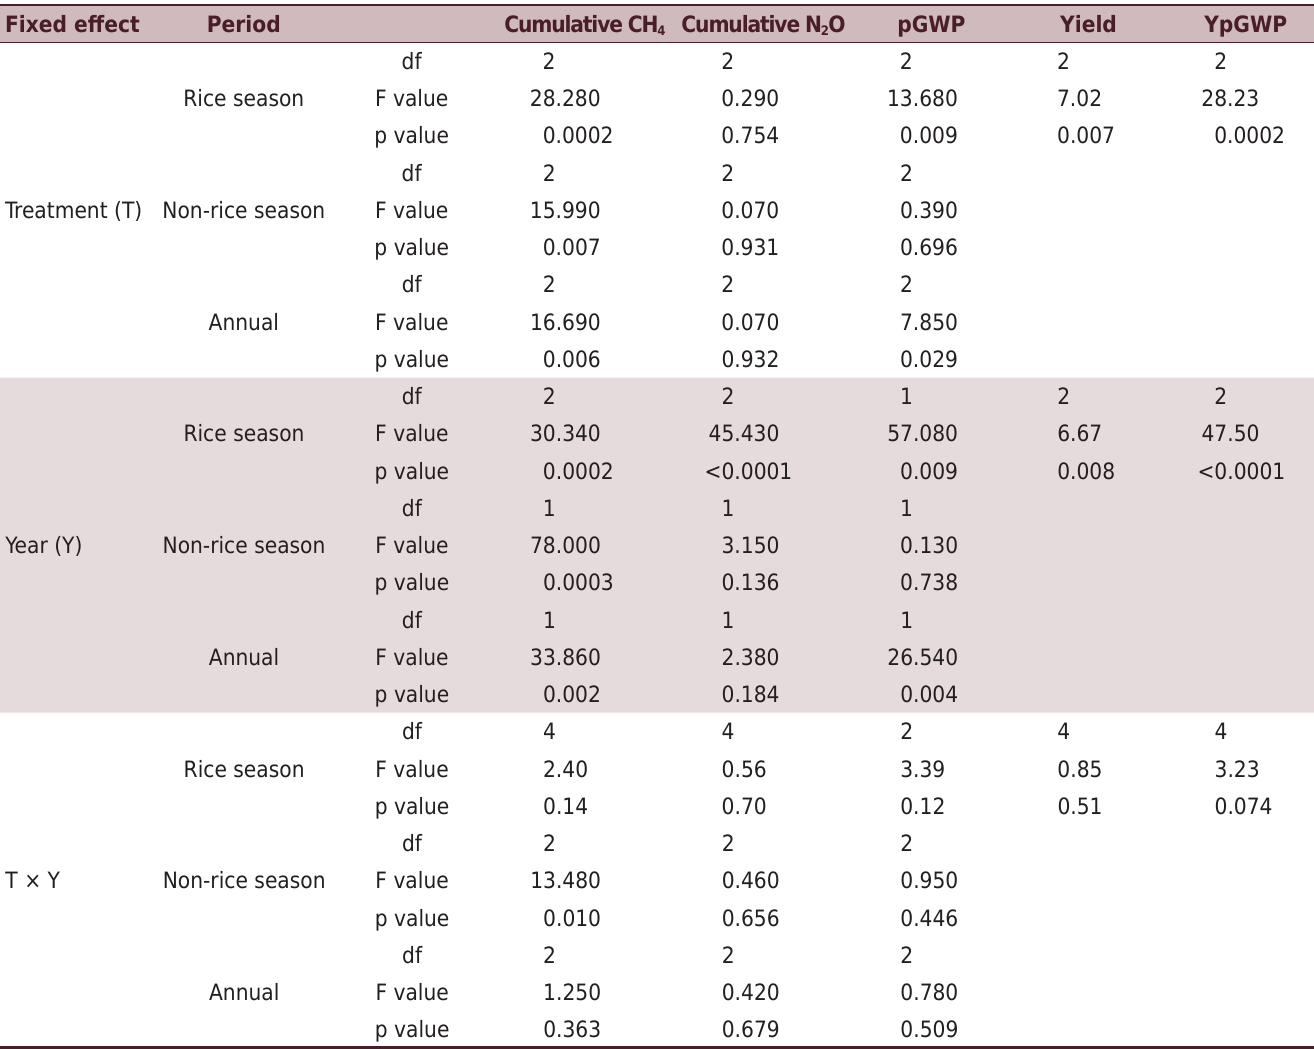
Table 2. Summary statistics: significance of the fixed effects treatment (T), year (Y), and T × Y interaction on the dependent variables (cumulative soil CH 4 and N 2 O emissions, pGWP, rice grain yield, and YpGWP) in the rice and non-rice seasons, and annual results (rice + non-rice seasons), for a paddy rice field at different crop management levels in southern Brazil Fixed